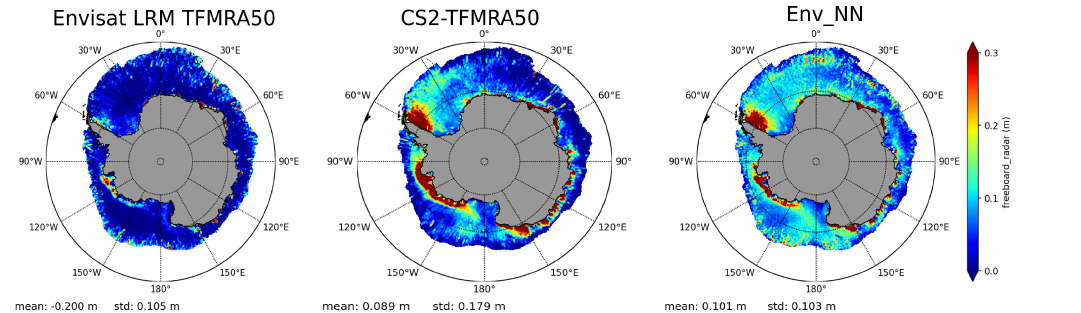
Figure 3. Maps of annual mean radar freeboard of Envisat LRM TFMRA50 ( left ), CS2-TFMRA50 ( middle ) and the Envisat LRM data calibrated on CS2-TFMRA50 using the neuronal network ap- proach (Env-NN, right ), for the 2011 common flight period.